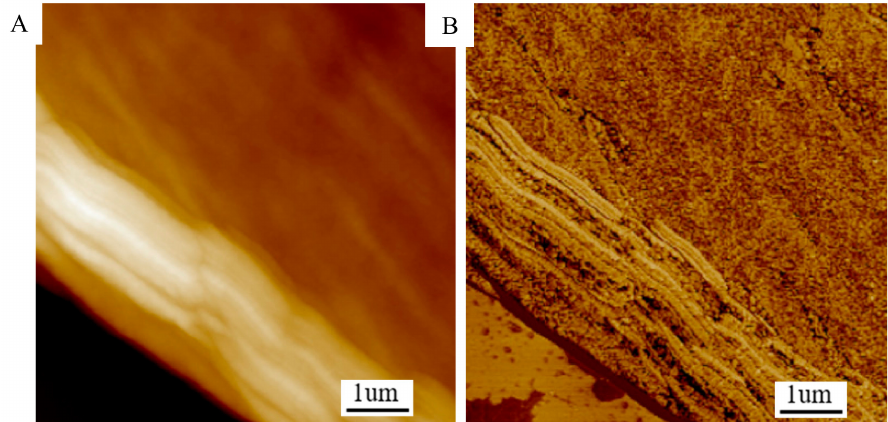
Figure 4. Atomic force microscopy (AFM) micrograph of the longitudinal surface of a poplar catkin fiber (( A ) height map; ( B ) phase